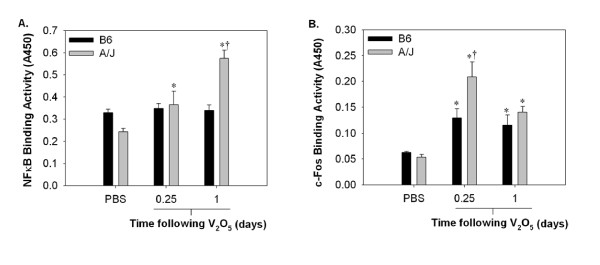
NFκB and c-Fos are differentially regulated in A/J and B6 mice following V2O5 instillation. Nuclear binding activity for A.) NFκB and B.) c-Fos were determined by transcription factor ELISA TransAM kits in nuclear protein extracts (8 μg) prepared from the lungs of chronic V2O5 treated mice (n = 3-6/group). *, significantly different than strain-matched PBS controls (P < 0.05). †, significantly different than time-matched B6 mice (P < 0.05).